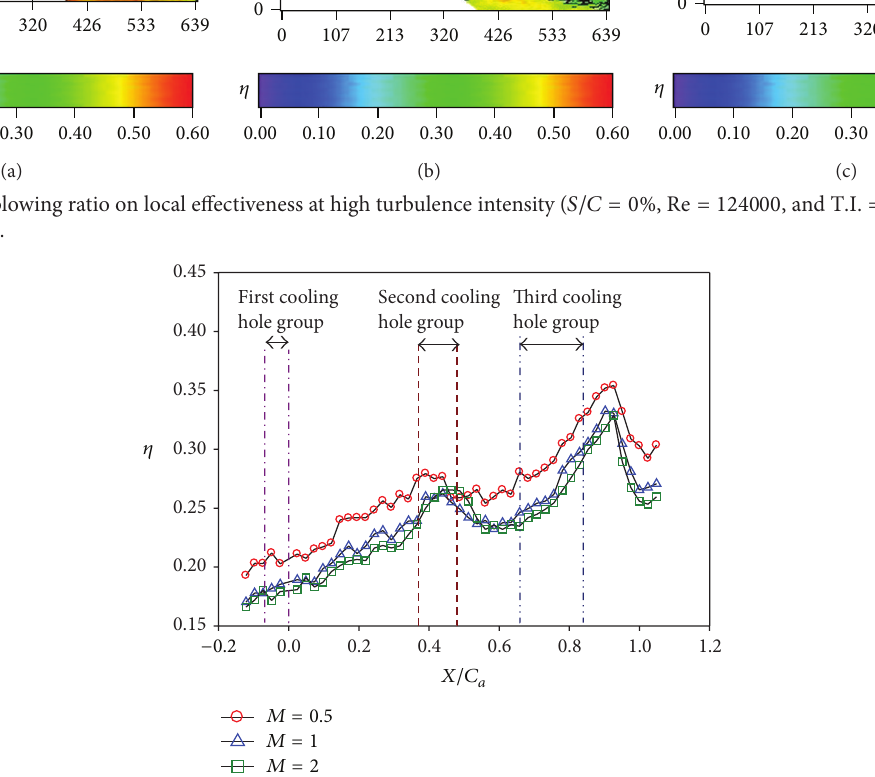
Figure 11: Effect of blowing ratio on averaged effectiveness at high turbulence intensity ( 𝑆/𝐶 = 0 %, Re = 124000 , and T . I . = 12